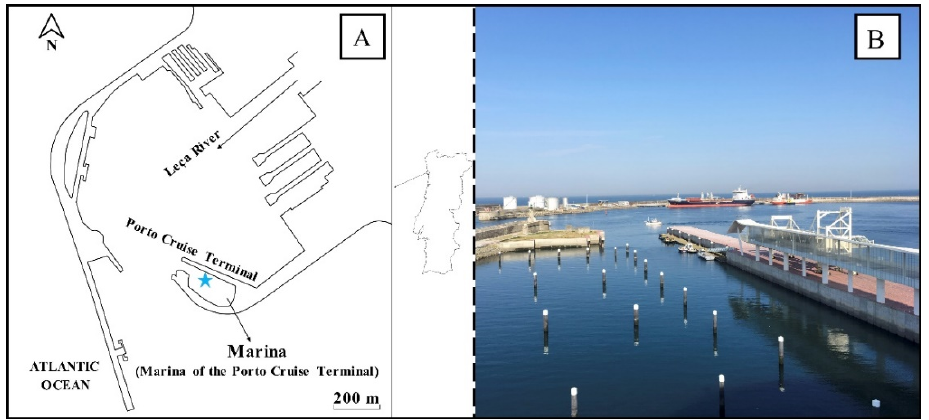
Figure 1. ( A ) Schematic representation of the study area, ( B ) photo of the marina of the Porto Cruise Figure 1. (A) Schematic representation of the study area, (B) photo of the marina of the Porto Cruise Terminal. (cid:70) Floating wetland island location. Terminal. Floating wetland island location.